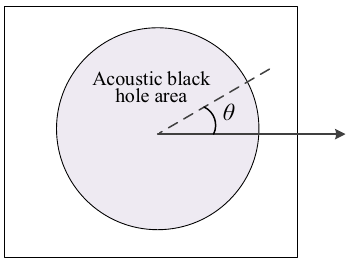
Figure 1: Diagram of polar coordinates of two - dimensional acoustic black hole